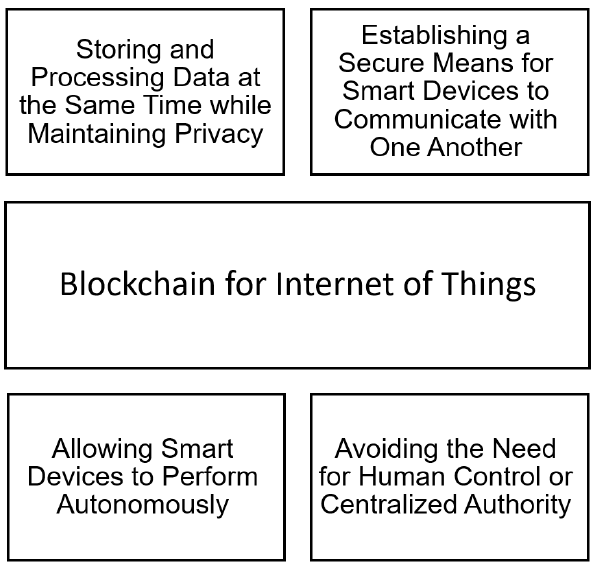
Figure 7. Blockchain for Internet of